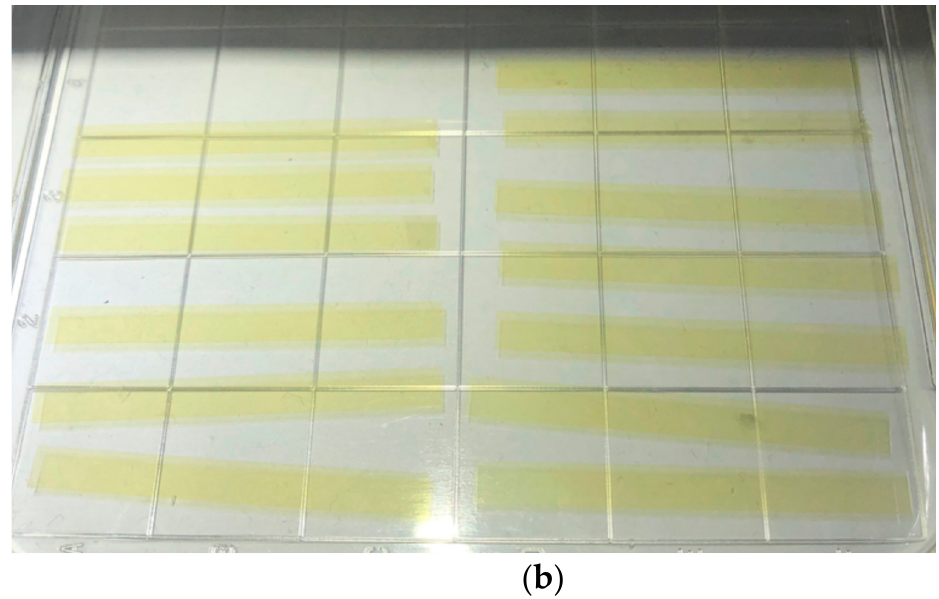
Figure 2. Test samples. ( a ) Dimensions of the rectangular test sample. ( b ) Released PSPI samples placed on PDMS.